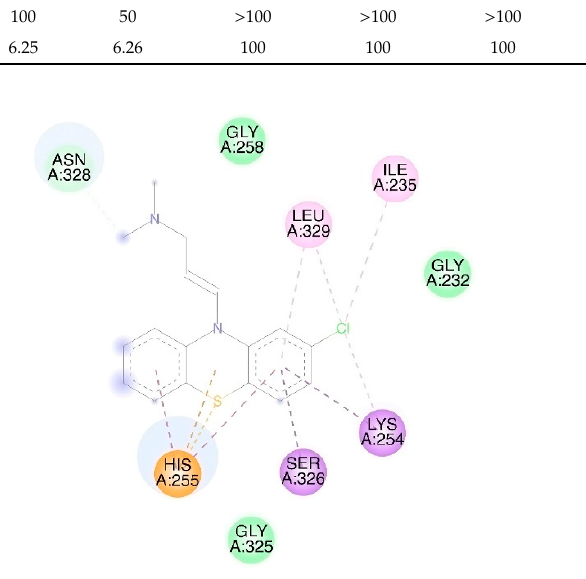
Figure 2. 2D visualization of interaction with the lowest EFEB between CPZ and FtsA ( − 8.7 kcal / mol)